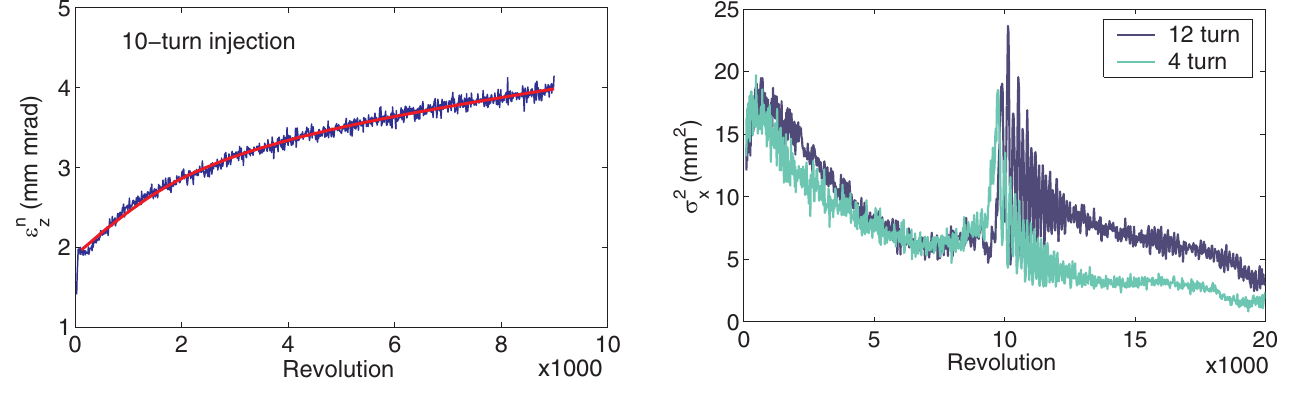
, initial vertical normalized emittance. Top right: parameter b 0